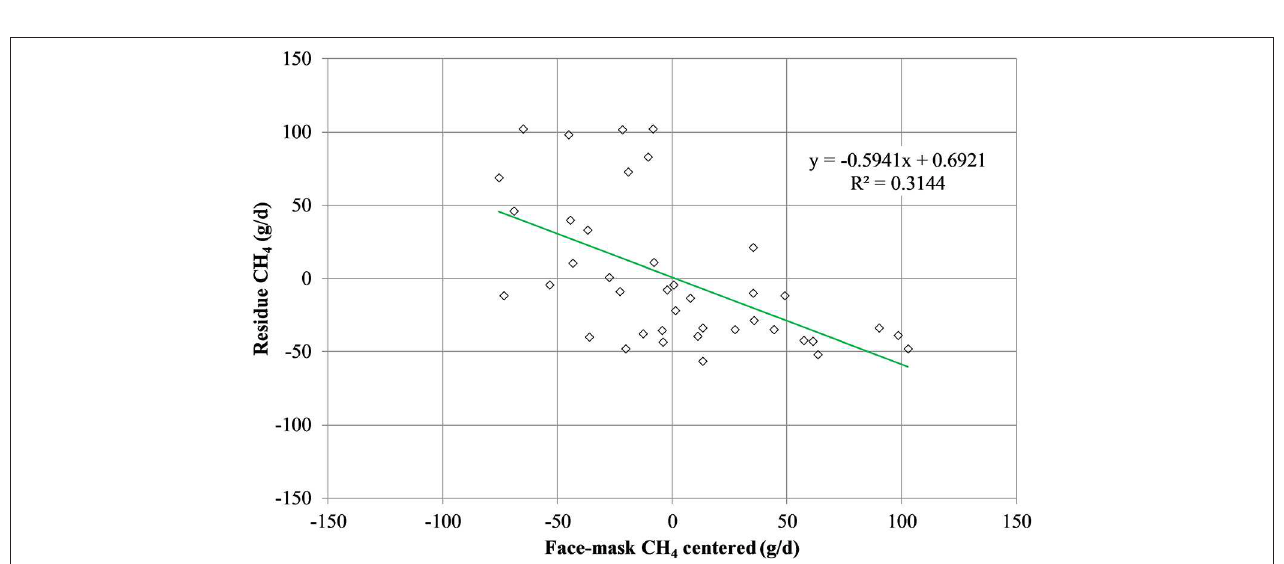
FIGURE 2 | Diurnal pattern of CH 4 production (g/d) as measured by the chamber ( (cid:7) ) and by the face-mask ( △ ) after feeding. The arrows represent the schedule of feeding (10:00 and 15:00).